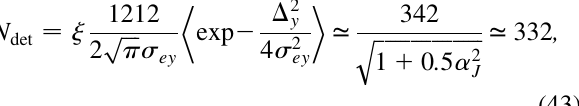
(cid:1) 10 MW . (a) As a function of BPM ‘ (cid:1) 0 : 25 . (b) As a function of beam jitter ( (cid:10) ) with the BPM resolution J J